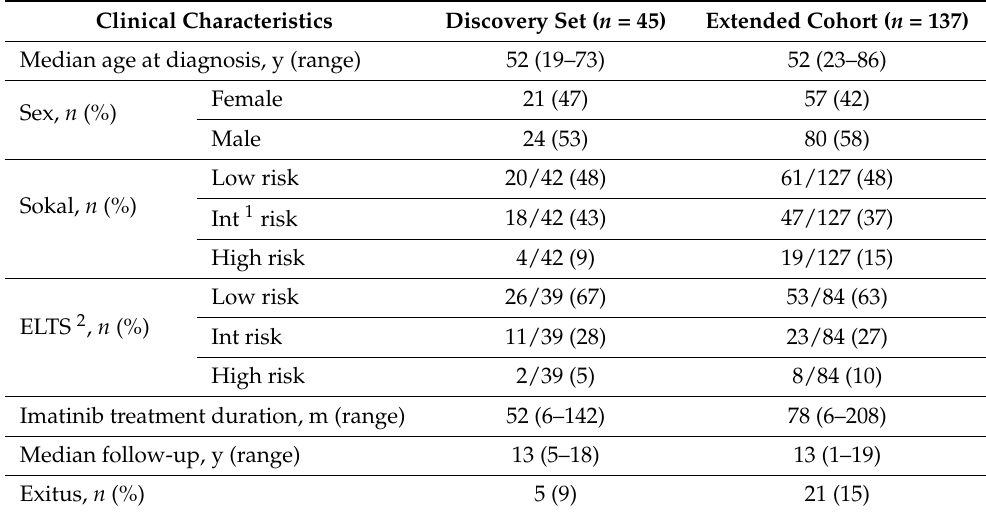
Table 1. Patients’ characteristics divided by the discovery set and the extended cohort. Clinical